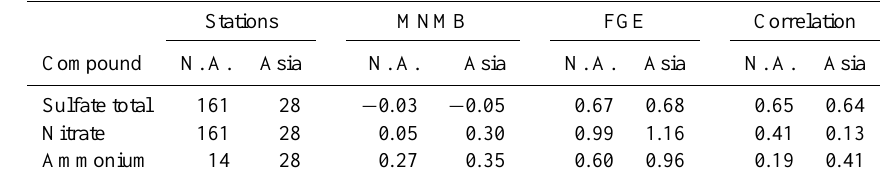
Table 12. Secondary inorganic aerosol statistics of RACMSIA simulation against daily EMEP observations. Number of Number of Compound stations observations